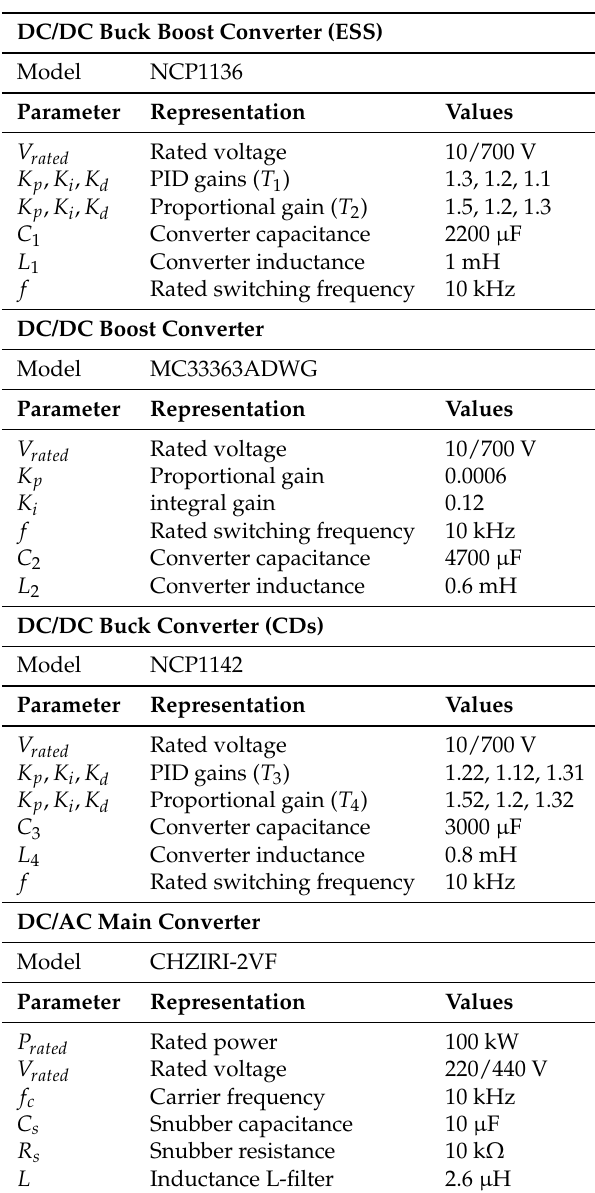
Table 4. Technical data of